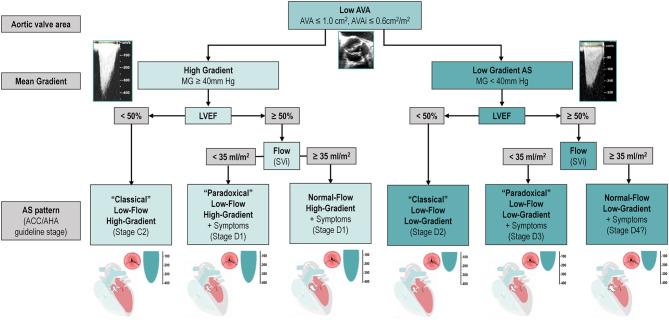
Classification and Characterization of the different types of AS according to AVA, Gradient, LVEF and Flow. The classification of types of AS, including only the categories associated with symptoms and/or depressed LVEF. It does not include stage C1 (i.e., patients with high-gradient AS, no symptoms, and preserved LVEF). Question mark indicates stage labels that are proposed by the authors but are not included in the guidelines and will need to be further tested and validated. ACC, American College of Cardiology; AHA, American Heart Association; AS, aortic stenosis; AVA, aortic valve area; AVAi, indexed aortic valve area; LVEF, left ventricular ejection fraction; MG, mean gradient; SVi, stroke volume index.